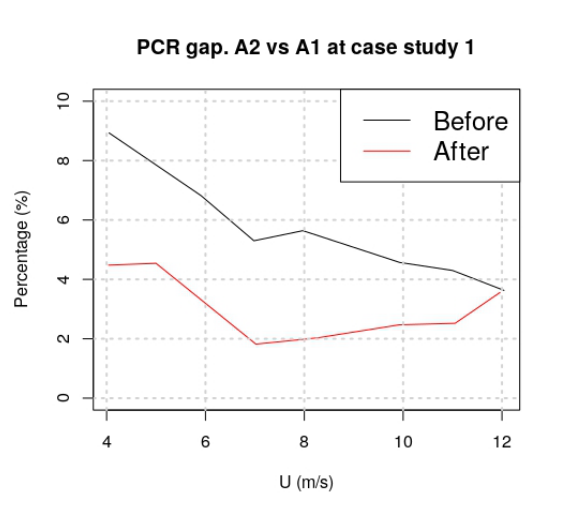
Figure 11. PCR gap reduction after calibration for turbine A2.